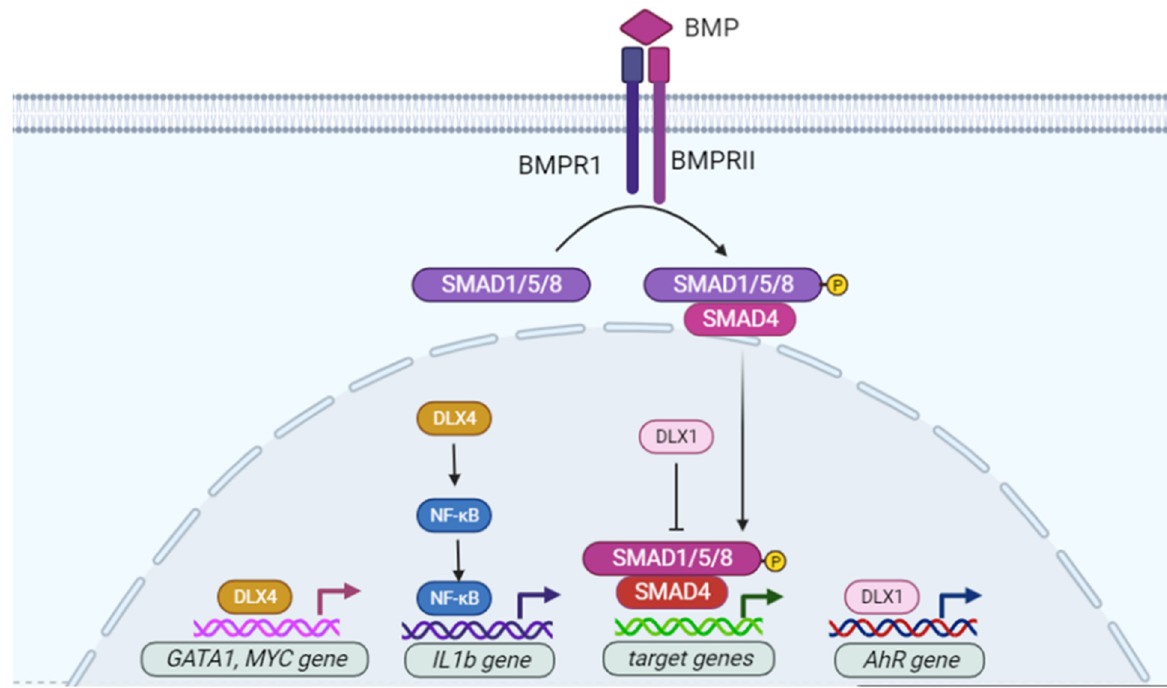
Figure 3. Role of DLX4 in hematopoiesis. DLX1 regulates BMP4 signaling via binding to SMAD4 and inhibiting its transactivation activity. DLX1 also directly regulates the expression of transactivating aryl hydrocarbon receptor ( AhR ) during T/B cell differentiation. DLX4 also enhances NF- κ B signaling to promote IL1 β production in a megakaryocytic transcriptional program. In addition, DLX4 has been shown to sustain the viability of K562 erythroleukemia cells by promoting the expression of GATA1 and MYC